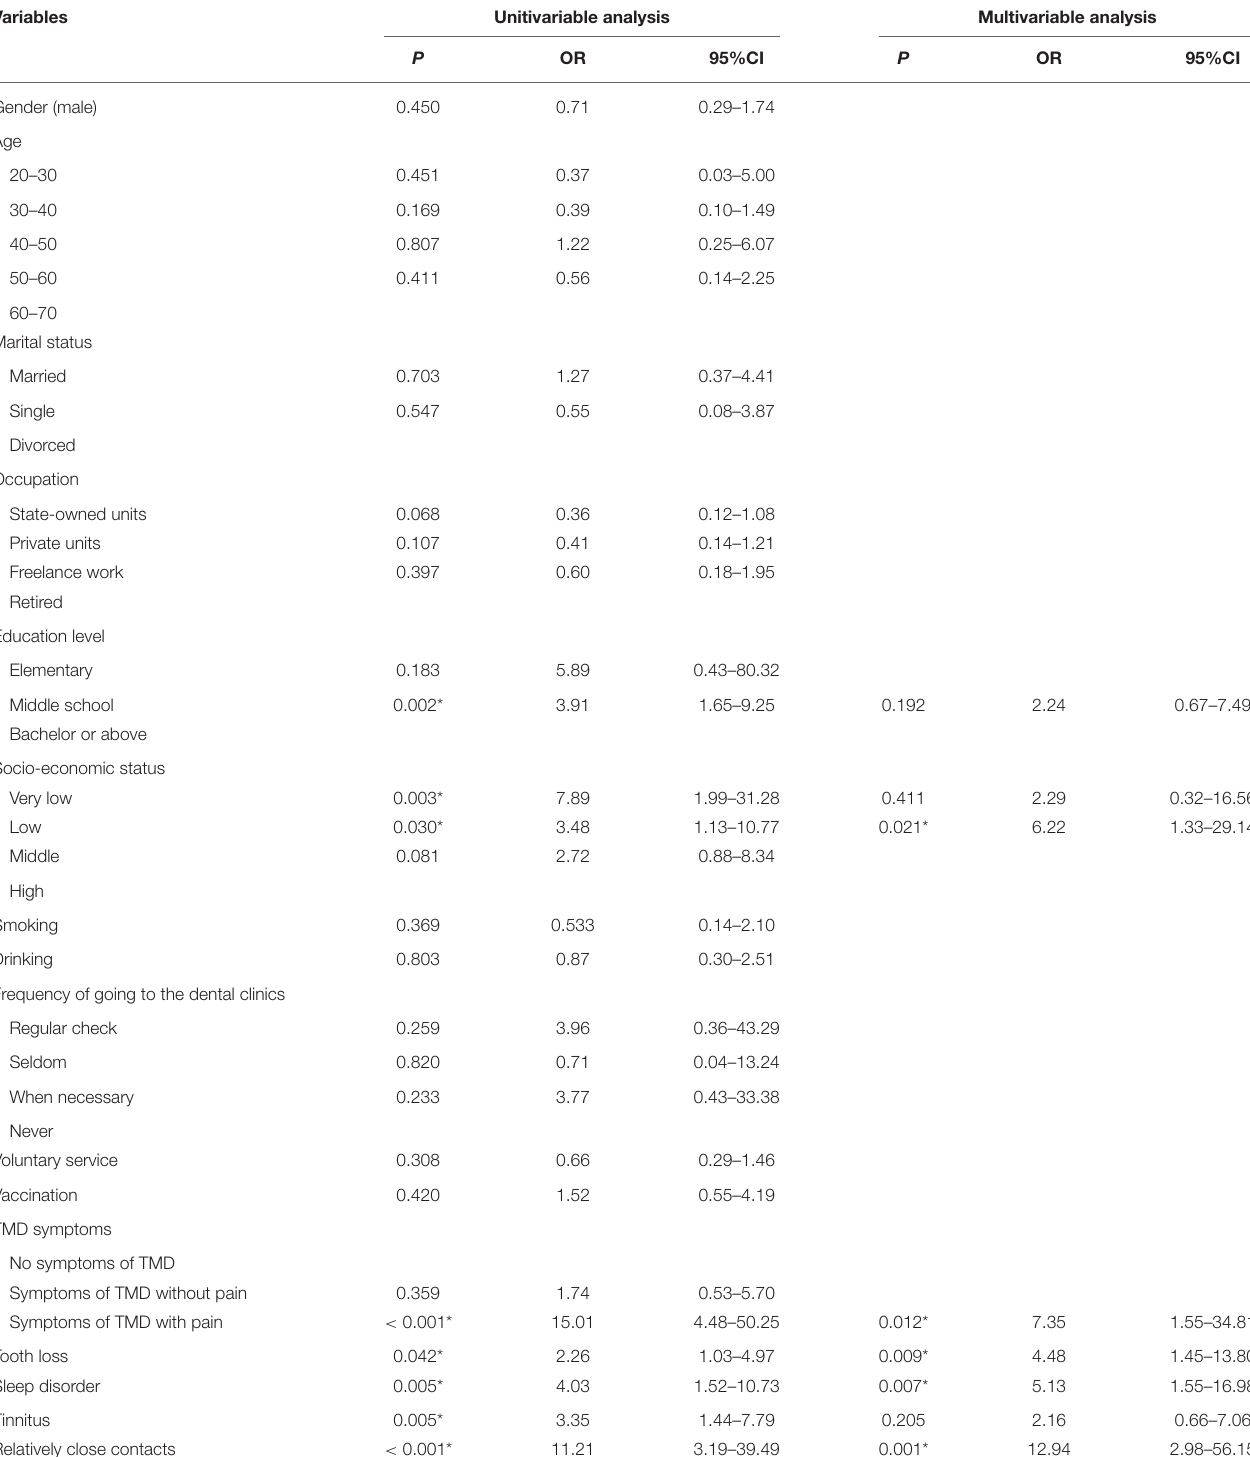
TABLE 4 | Factors associated with elevated